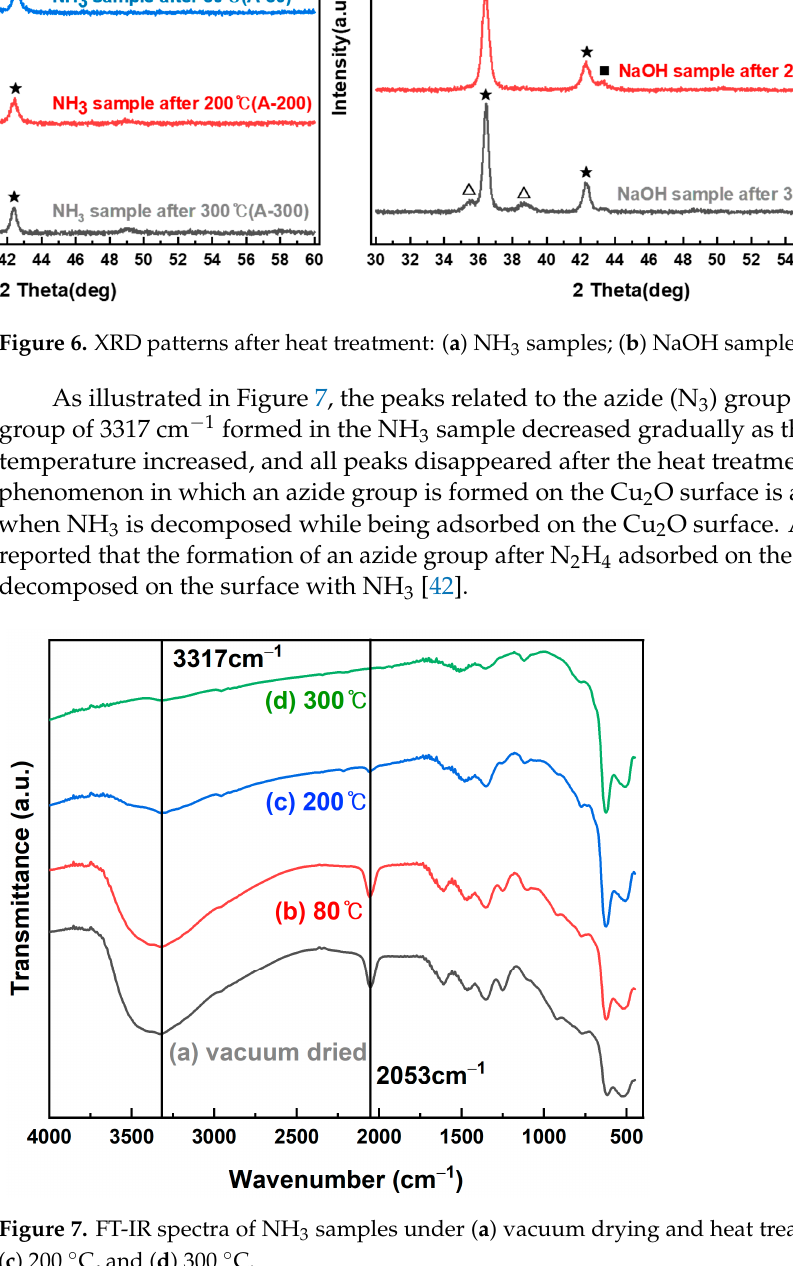
Figure 7. FT-IR spectra of NH 3 samples under ( a ) vacuum drying and heat treatment at ( b ) 80 °C, ( c ) 200 °C, and ( d ) 300 °C. ( c ) 200 ◦ C, and ( d ) 300 ◦